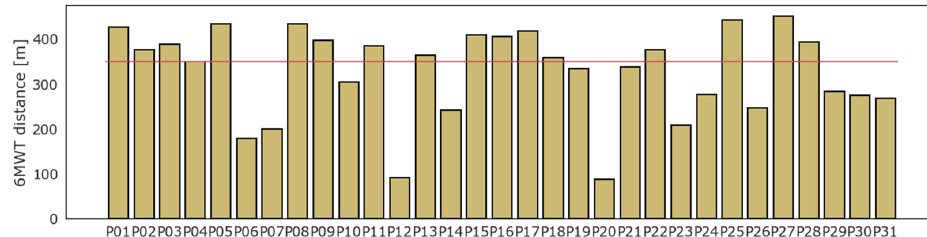
Figure 2. Six minutes walking test: results in distance (meters).